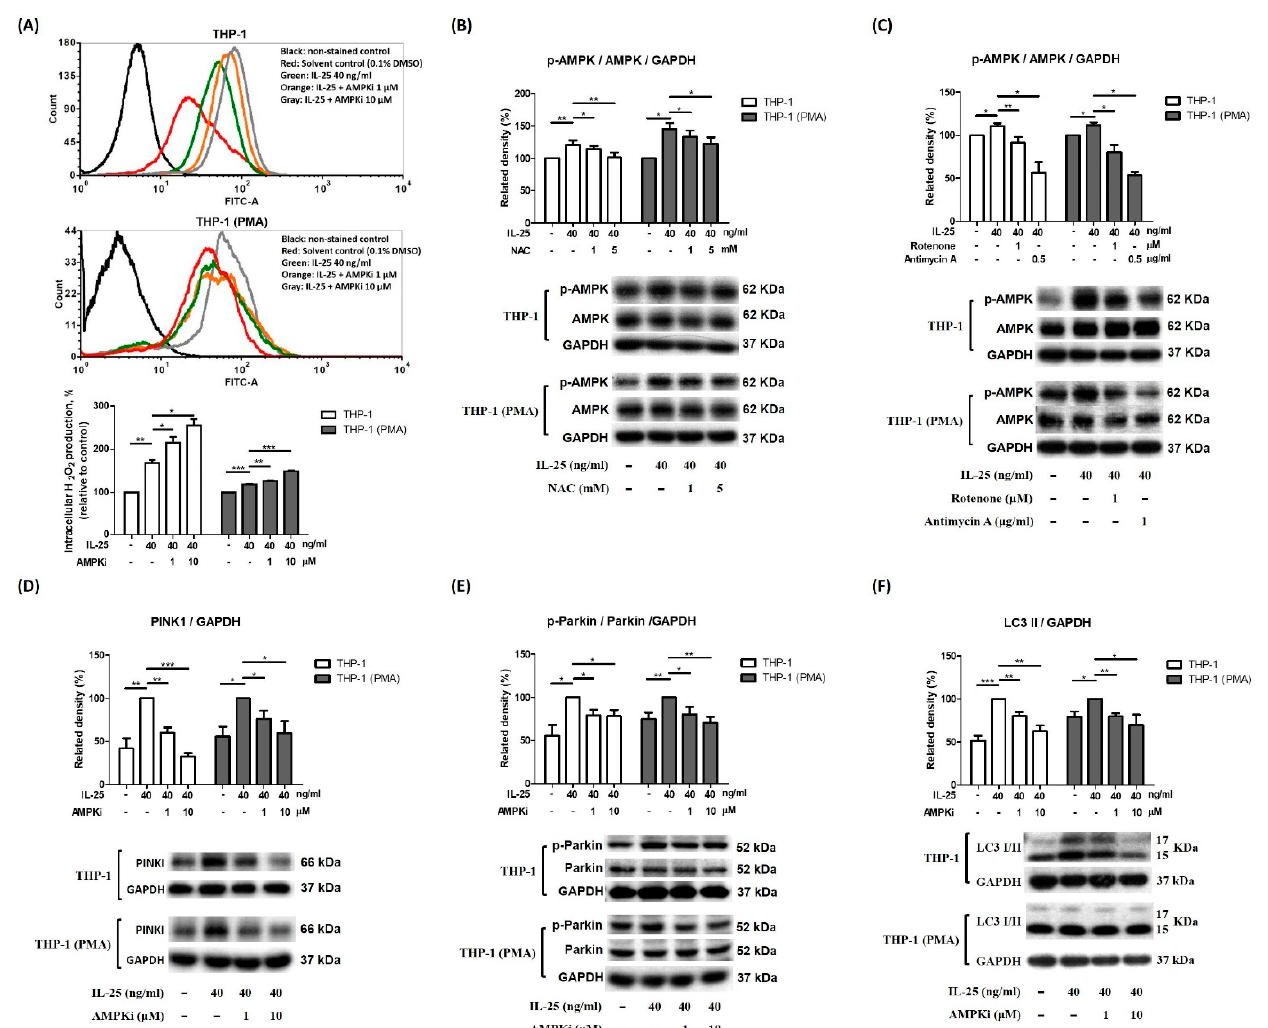
Figure 4. IL-25-induced mitophagy-related proteins expression via ROS-AMPK pathway in THP-1 cells and THP-1 derived macrophages. ( A ) representative histograms of cell counts (counts) vs. DCF fluorescence (FITC-A) (above), and the mean fluorescence intensity (MFI) of DCF expressed as a percentage relative to control cells (below). ( A ) After pretreatment with solvent control (0.1% DMSO) or AMPKi (1 and 10 μ M) for 0.5 h, the IL-25-induced ROS production in THP-1 cells (white bar) and THP-1 derived macrophages (gray bar) were measured. n = 3, means ± SD. ( B ) After medium alone or NAC (1 and 5 mM) pretreatment for 0.5 h followed by IL-25 treatment for 8 h, IL-25-induced p-AMPK expression in THP-1 cells (white bar) and THP-1 derived macrophages (gray bar) were determined. n = 4, means ± SD. ( C ) After pretreatment with solvent control (0.1% DMSO), rotenone (1 μ M) or antimycin A (0.5 μ g/mL) for 0.5 h followed by IL-25 treatment for 8 h, IL-25-induced p-AMPK expression in THP-1 cells (white bar) and THP-1 derived macrophages (gray bar) were deter-mined. n = 3, means ± SD. After pretreatment with solvent control (0.1% DMSO) or AMPKi (1 and 10 μ M) for 0.5 h followed by IL-25 treatment for 8 h, the PINK1 ( D ), p-Parkin ( E ), and LC3 I/II ( F ) protein levels were determined by western blot. n = 3, means ± SD. * p < 0.05, ** p < 0.01, and *** p <